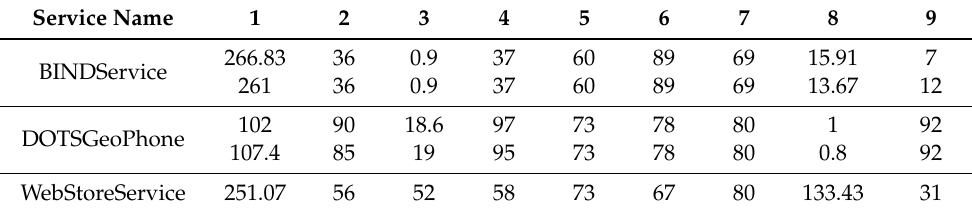
Figure 9. ACM recognition case study. Table 5. Case study web services feature description.